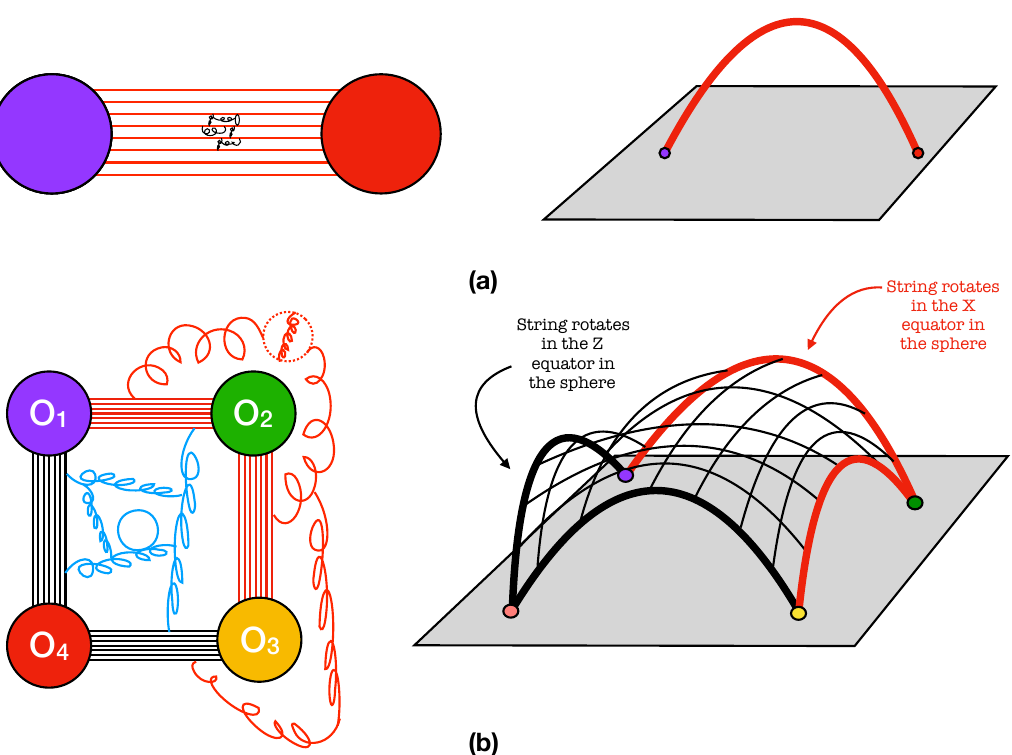
Figure 2 . Each bundle of propagators in the (cid:12)eld theory can be thought of as a very heavy BMN string geodesic which is protected by supersymmetry. The octagon is the sum of all Feynman diagrams inside (or outside) the tree level frame or, equivalently, the top (or bottom) of the folded string stretching between four consecutive geodesics. At genus zero, the folded string has a top and bottom and hence the result is given by O 2 in agreement with the (cid:12)eld theory result.